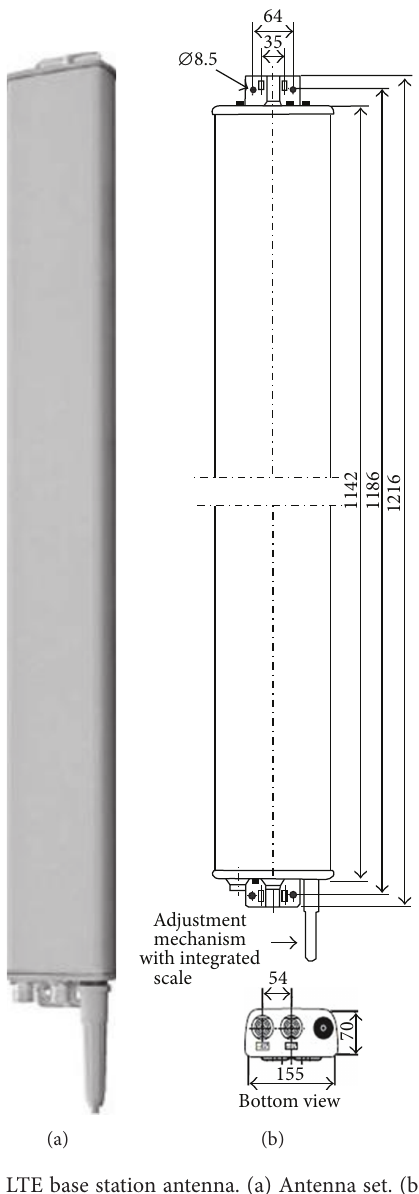
Figure 2: LTE base station antenna. (a) Antenna set. (b) Antenna dimensions